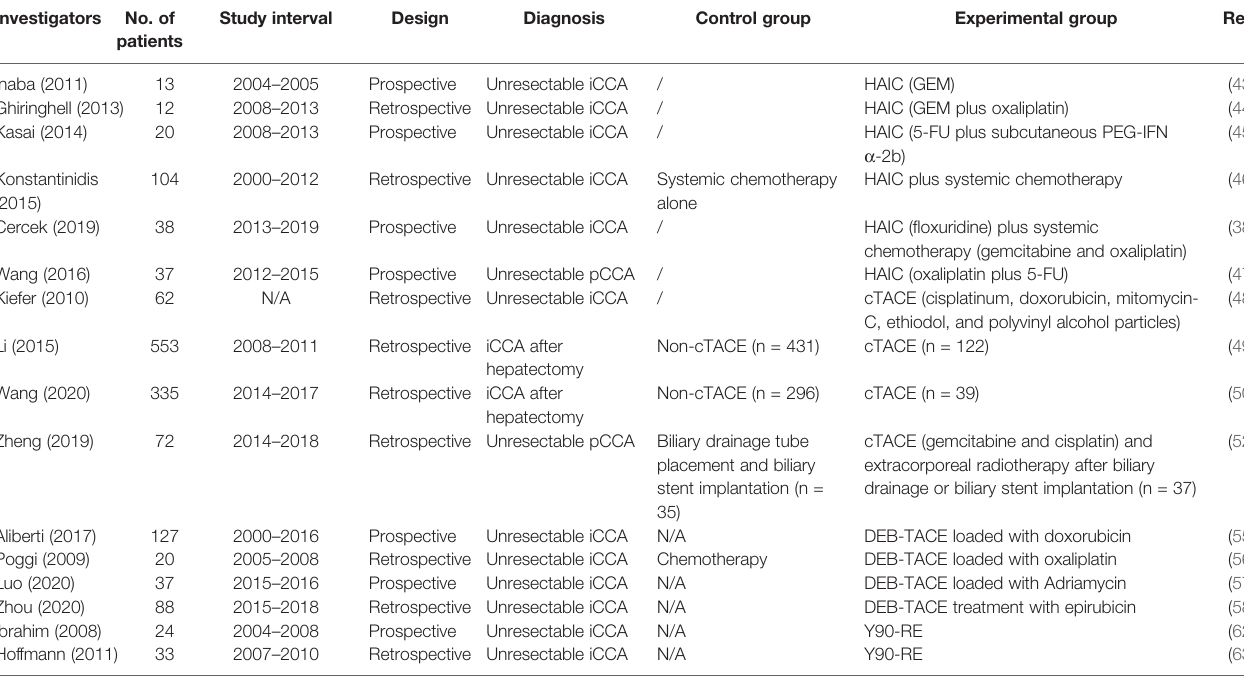
TABLE 1 | Study design and characteristics within included studies for